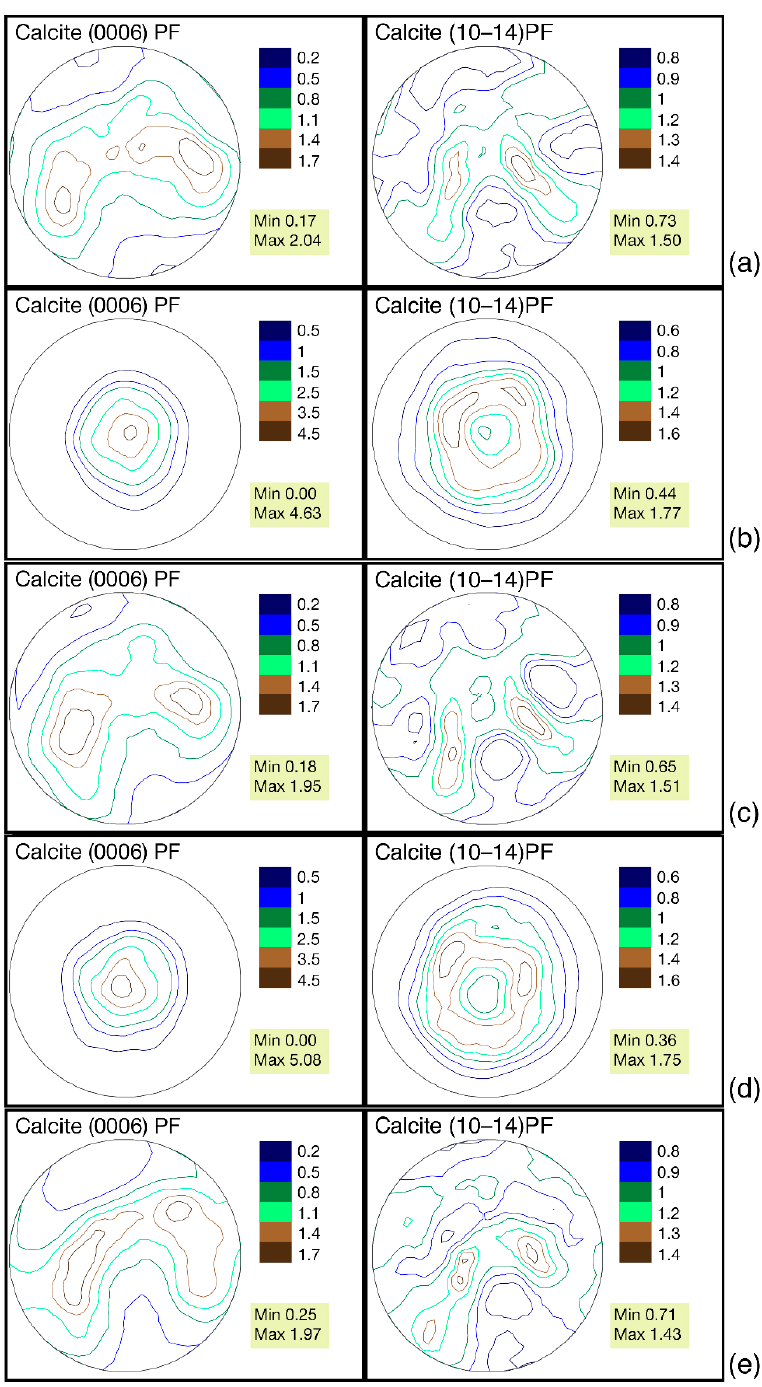
Figure 4. Pole figures of Gryphaea dilatata Sowerby, 1816, from different locations: ( a ) Calcite pole figures of the left valve of Gryphaea dilatata Sowerby, 1816, Kursk region, near town of Zheleznogorsk, Mikhailovsky quarry, Middle Jurassic, Middle–Upper Callovian; ( b ) Calcite pole figures of the right valve of Gryphaea dilatata Sowerby, 1816, Same; ( c ) Calcite pole figures of the left valve of Gryphaea dilatata Sowerby, 1816, Oryol region, Kromy district, sand quarry near the village of Sukhochevo, Middle Jurassic, Middle Callovian; ( d ) Calcite pole figures of the right valve of Gryphaea dilatata Sowerby, 1816, Same; ( e ) Calcite pole figures of the left valve of Gryphaea dilatata Sowerby, 1816, Moscow region, Shatura district, sand quarry on the outskirts of the town of Roshal, Middle Jurassic, Callovian–Upper Jurassic, Lower Oxfordian.